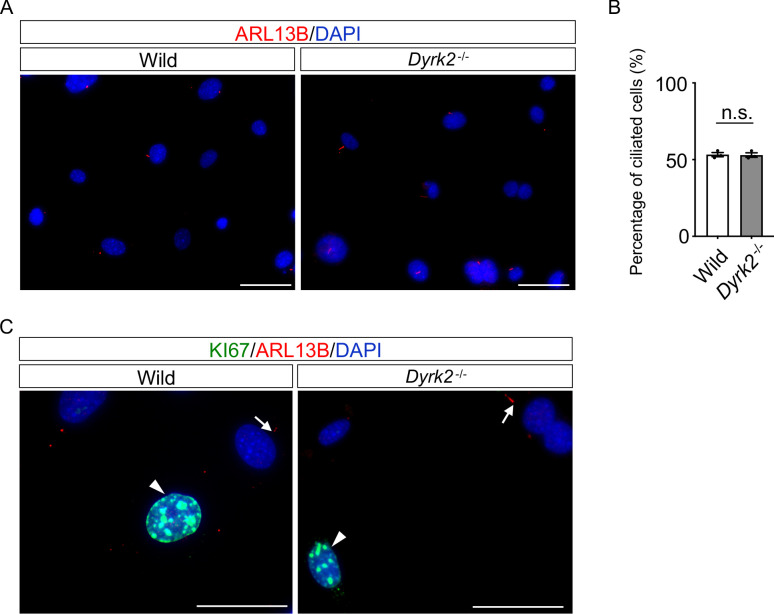
Quantification of the proportion of ciliated cells in wild-type and Dyrk2-/- MEFs.(A, B) Proportion of ciliated cells in wild-type and Dyrk2-/- MEFs. Primary cilia of wild-type and Dyrk2-/- MEFs were immunostained with ARL13B (A). Measurements of proportion of ciliated cells in wild-type and Dyrk2-/- MEFs using ARL13B as a cilia axoneme marker (B). Data are presented as the means ± SEM (n = 3 biological replicates per condition;>150 cells were scored for each experiment). The statistical significance between wild-type and Dyrk2-/- was determined by the Student’s t-test. (C) Proportion of ciliated cells in cell-cycling wild-type and Dyrk2-/- MEFs. Wild-type and Dyrk2-/- MEFs cultured under 10% FBS containing medium at low density were immunostained with KI67 and ARL13B. Nuclei were stained with DAPI. Arrowheads and arrows indicate non-ciliated/KI67-positive cycling cells and ciliated/KI67-negative ones, respectively. Scale bars, 50 µm.Figure 4—figure supplement 3—source data 1.Source data for Figure 4—figure supplement 3B.